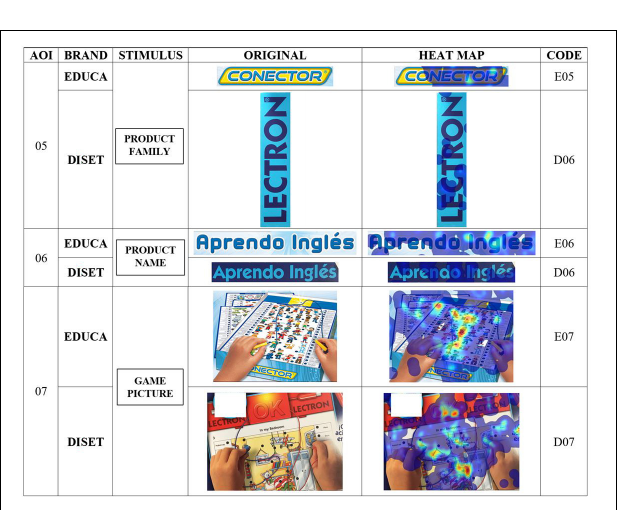
FIGURE 3 | Heat maps of stimuli. Part 2. Relation to scale. Source: Prepared by the